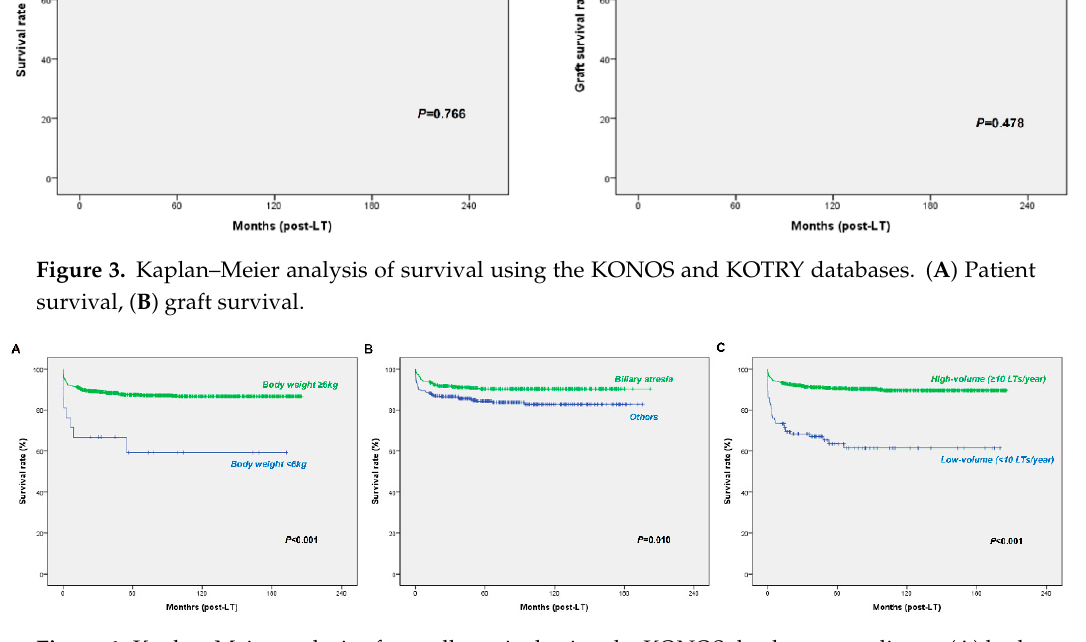
Figure 4. Kaplan–Meier analysis of overall survival using the KONOS database according to ( A ) body weight, ( B ) underlying disease, and ( C ) center case volume.